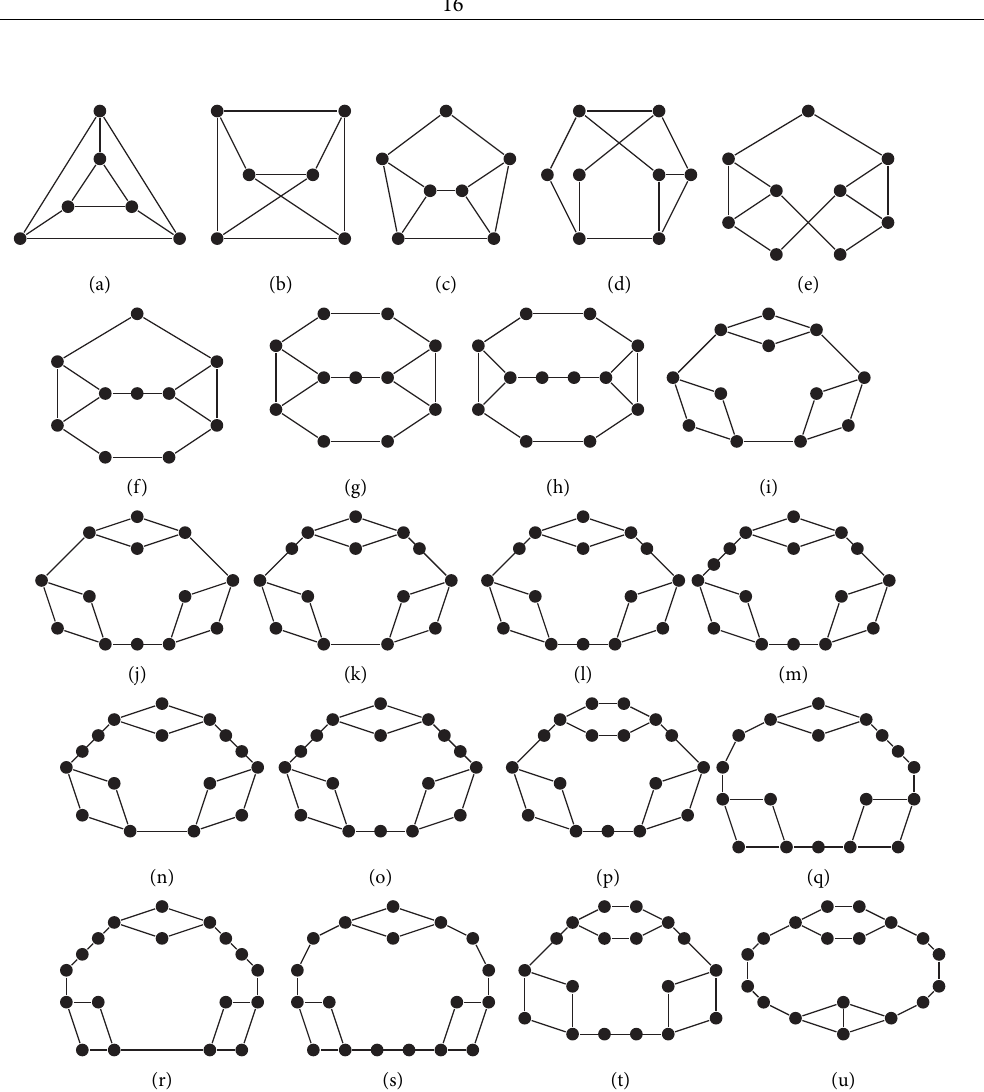
Figure 12: Tetracyclic graphs with minimum edge Mostar index of order n , 6 ≤ n ≤ 18. (a) G 1